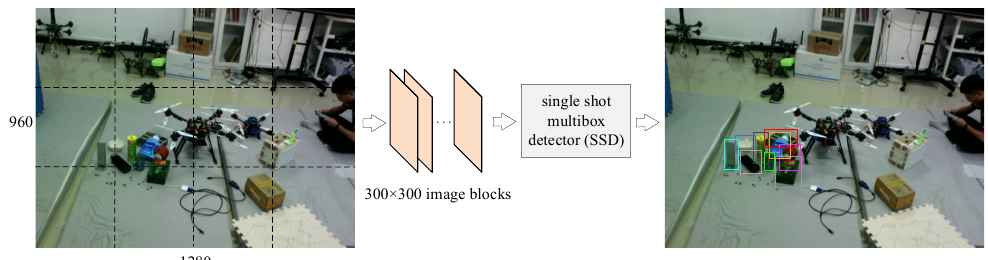
Figure 3. The process of object detection. The original image is cut into several 300 × 300 sub-images, and then the SSD algorithm is applied to each sub-image, respectively. Finally, these bounding boxes are mapped to the original